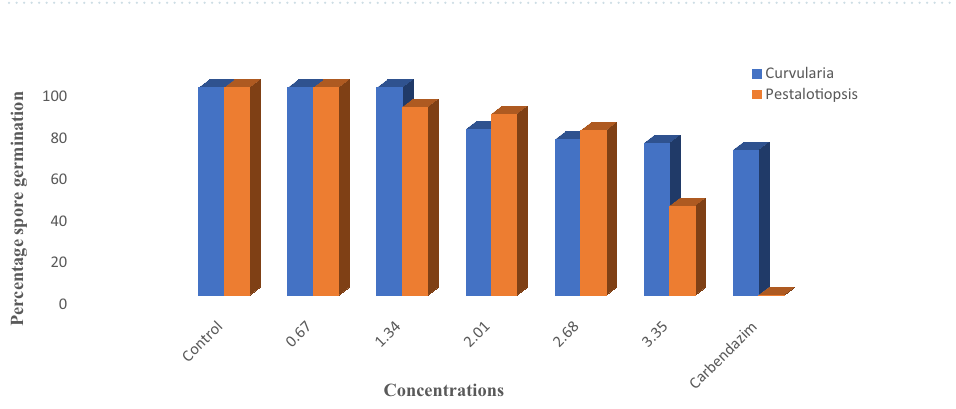
Figure 4. Effect of wood vinegar amended concentrations and carbendazim on spore germination of the